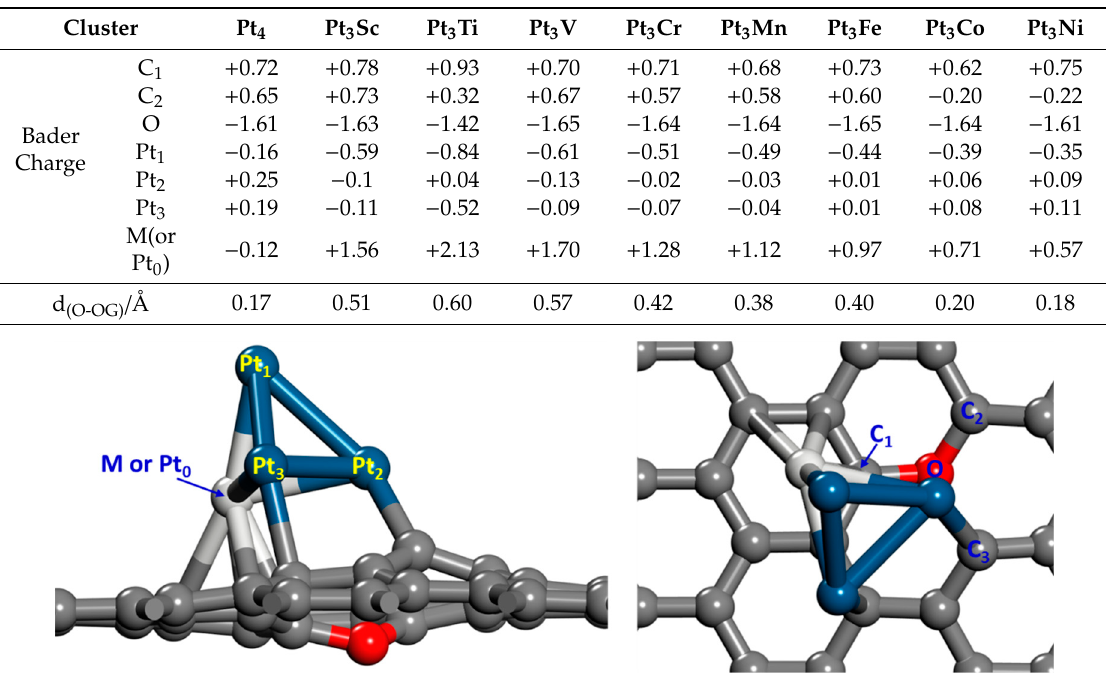
Table 1. Bader charges of the metal atoms, doped oxygen and the carbon atoms bonded with oxygen, and the distance between the doped oxygen atom and the graphene plane (d (O-OG) in Å). The corresponding atoms are labeled in the accompanying structures under the table.